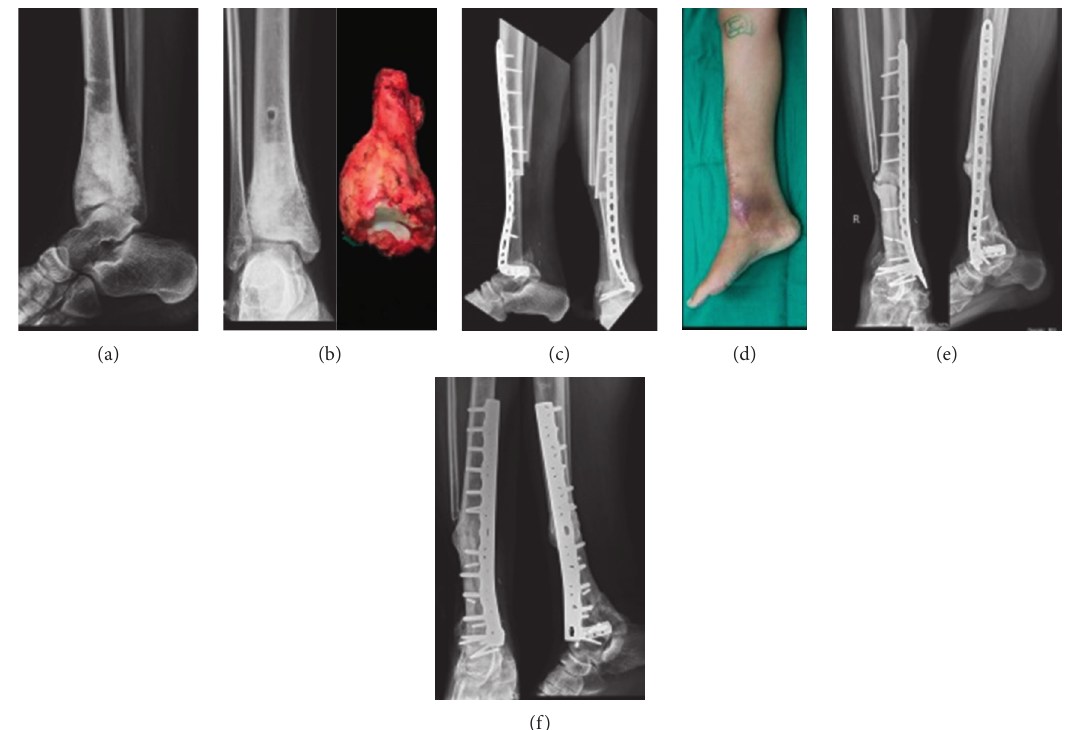
Figure 1: A 13-year-old female presented with a biopsy-proven distal tibia osteosarcoma (a), and following neoadjuvant chemotherapy, she underwent resection of the tumor (b) and reconstruction with centralization of ipsilateral fibula as a vascular graft (c). The midline incision was extended medially for plating across the ankle (d), and this posed a challenge with inadequate soft tissue cover over the reconstruction and led to a sinus formation. Plate breakage was observed at 39 months along with fibular hypertrophy and nonunion across the proximal junction (e), and this required bone grafting and plate exchange (f) to achieve